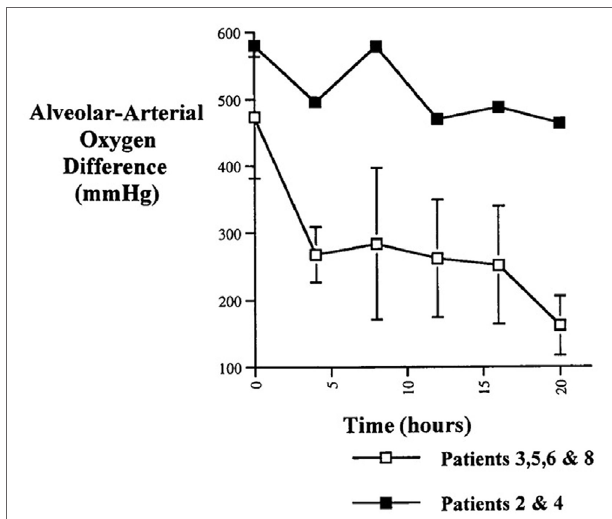
FigURe 10 | Time course of mean AaPO2 after the onset of reperfusion pulmonary edema. Comparison of mean AaPO2 in four patients with intact alveolar epithelial fluid clearance (open squares) to the patients with no net alveolar epithelial fluid clearance (solid squares). The data for Patients 3, 5, 6, and 8 are expressed as mean 6 SD. The data for Patients 2 and 4 are expressed as the average of the AaPO2 at each time point (45). Reprinted with permission of the American Thoracic Society. Copyright © 2017 American Thoracic